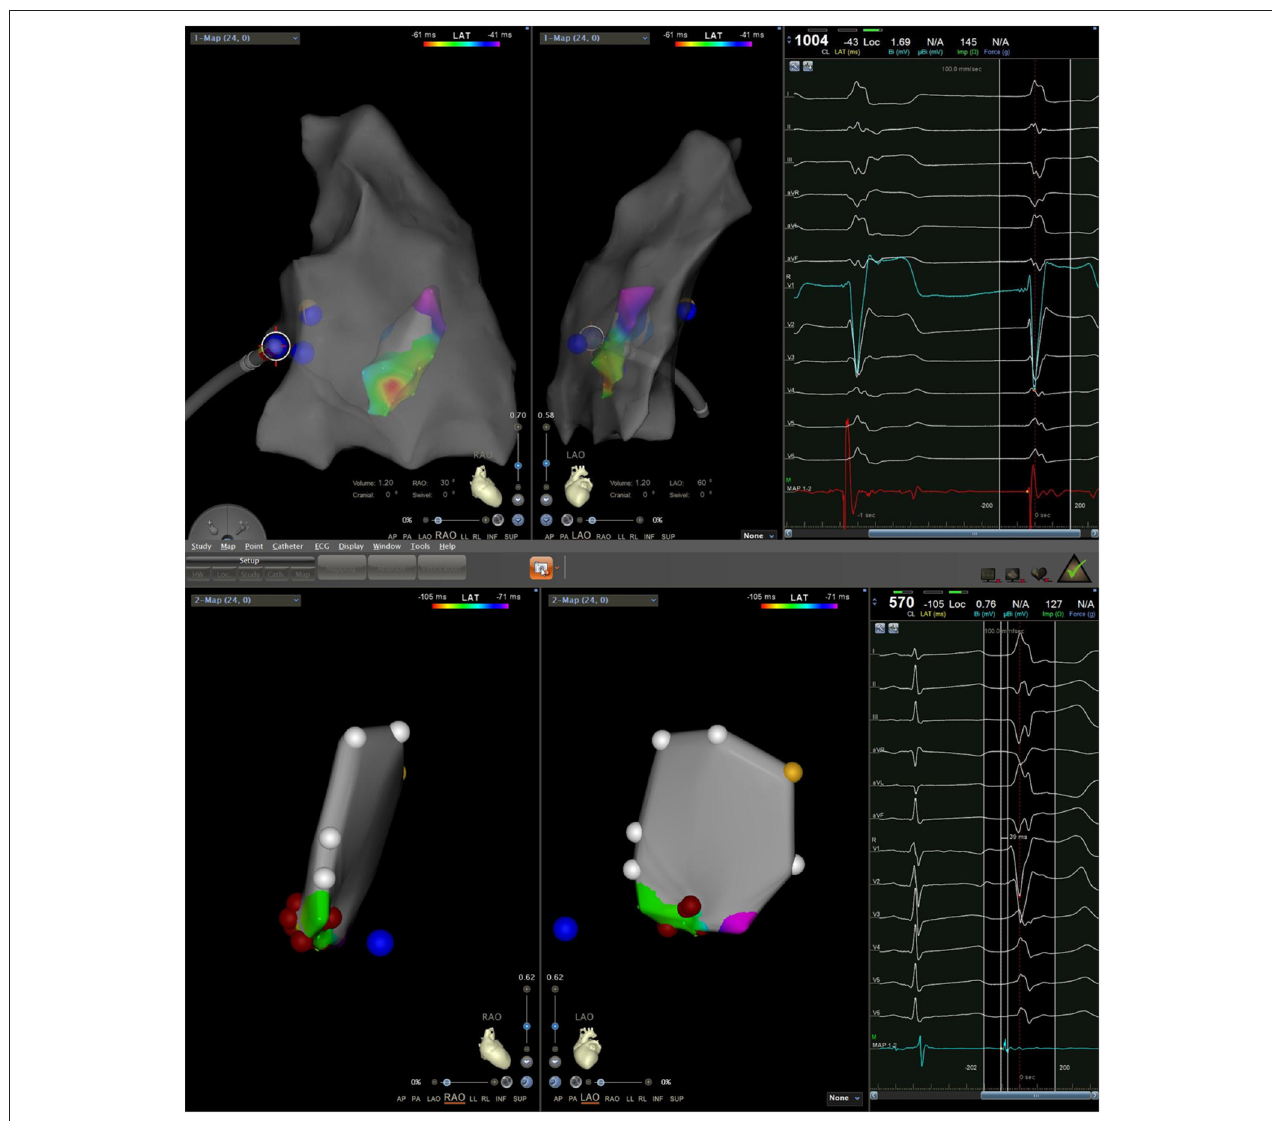
FIGURE 4 | Electrocardiogram (ECG) comparison between premature ventricular contraction (PVC) originating from the moderator band (MB) and the posterior-lateral wall of tricuspid annulus. In the figure above, the left ECG was MB origin, while the right was origin of the posterior lateral wall of the tricuspid annulus by pacing. In the figure below, the ECG was spontaneous PVC originating from the posterior-lateral wall of tricuspid annulus. PVC of MB origin has a sharper slope of downstroke in the precordial